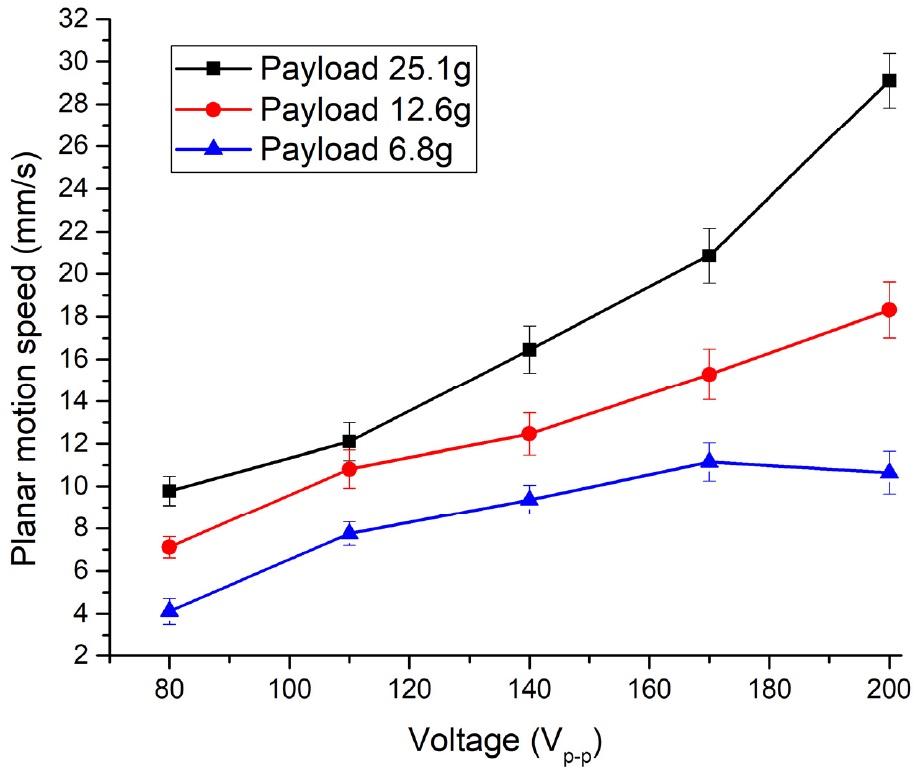
Figure 16. Dependence of planar velocity from excitation voltage when different payloads are applied.